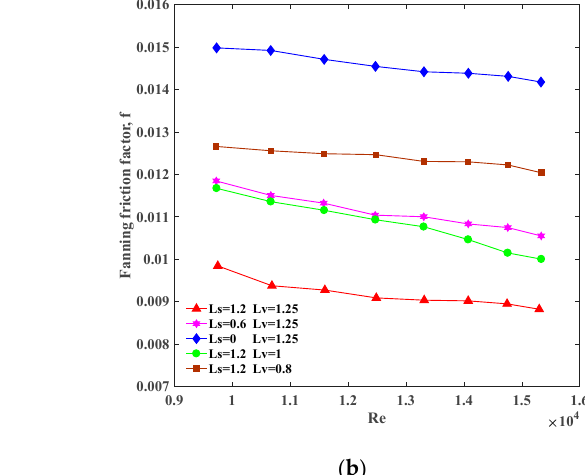
Figure 11. Performance evaluation criteria for different fin arrangements .